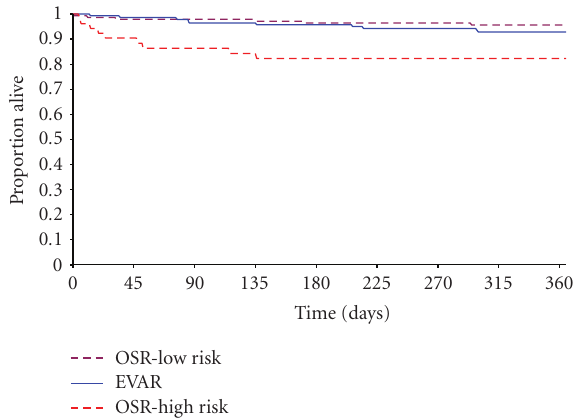
Figure 2: Kaplan Meier Survival Plots for EVAR, OSR HR, and LR patients up to 12 Months of Followup Kaplan